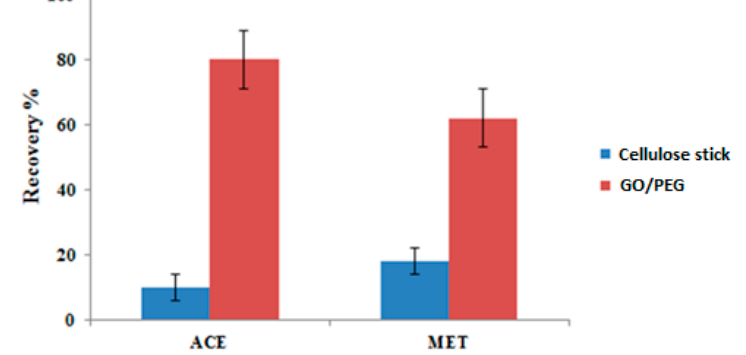
Figure 5. E ffi ciency of GO / PEG-stick compared to blank cellulose stick (1000 nmol L − 1 ). Figure 5. Efficiency of GO/PEG-stick compared to blank cellulose stick (1000 nmol L − 1 ).